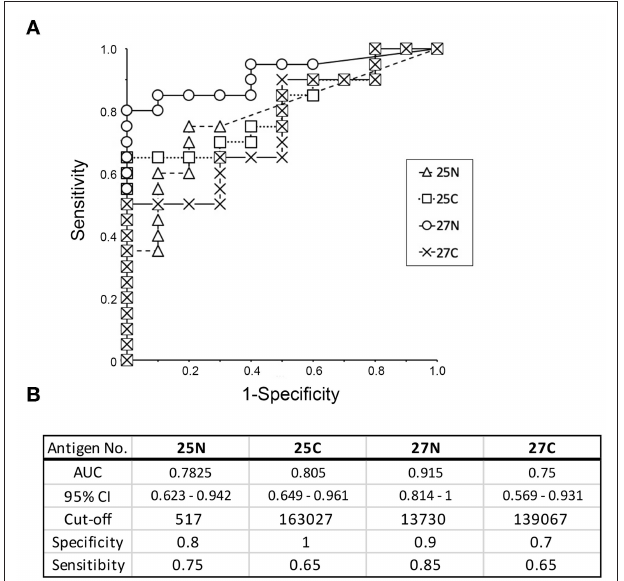
FIGURE 7 | Receiver operative characteristic (ROC) curve analysis to evaluate the diagnostic capacity of individual recombinant antigens (25N, 25C, 27N, and 27C) to distinguish between periodontitis patients and healthy individuals. (A) ROC curves were generated as described by Ekuseru-Toukei 2010 (Social Survey Research Information Co., Ltd.) using the spot intensities from the dot blot analysis ( Figure 6 ). (B) The values of AUC with 95% confidence interval (CI) and sensitivity/specificity with optimal cut-offs are presented in the lower panel. N, N-terminal half; C, C-terminal